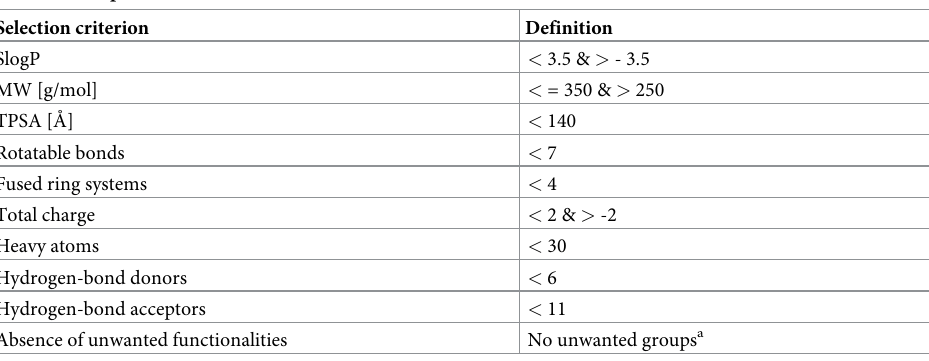
Table 1. Compound selection